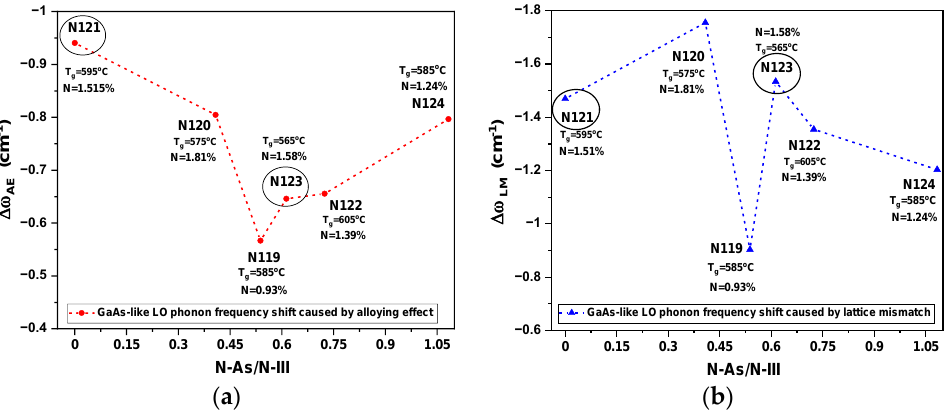
Figure 7. The dependences of GaAs-like LO phonon shift (determined from Raman spectra) caused by the alloying ( a ) and the strain ( b ) effects on the N-As / N-III ratio (calculated from XPS spectra) for investigated GaAsN/GaAs heterostructures.